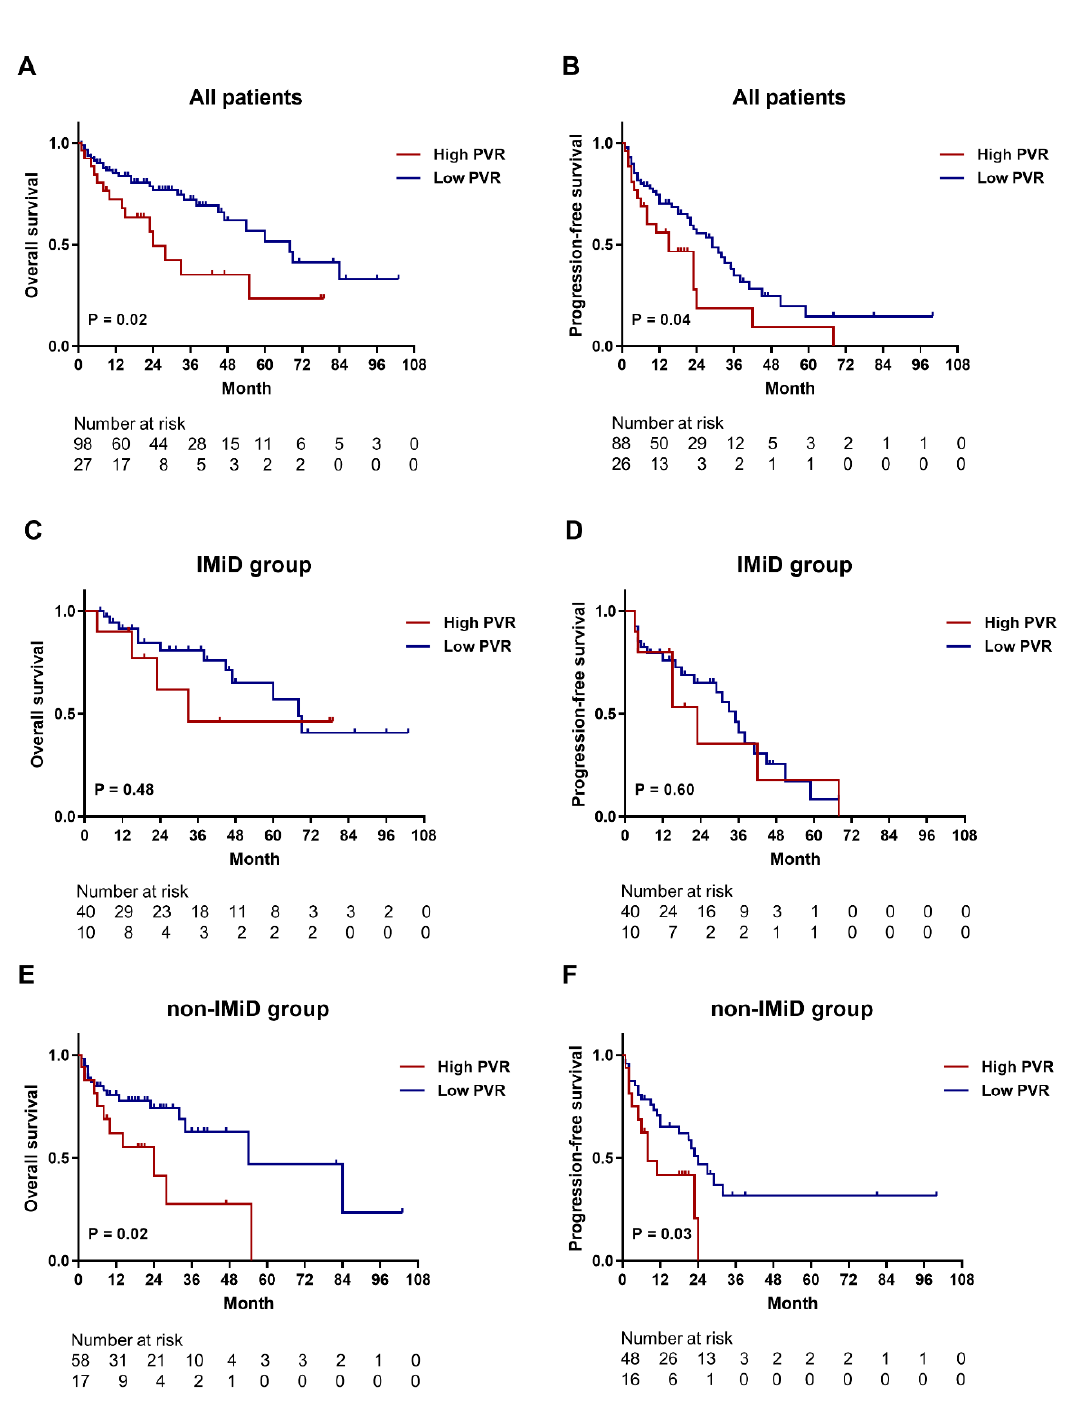
Figure 5. Kaplan–Meier survival curves for OS and PFS according to PVR expression. ( A , B ) OS and PFS curves for all patients. The median OS was 24 months in the high PVR-expression group and 68 months in the low PVR-expression group (n = 125). The median PFS was 15 and 29 months in the high and low PVR-expression groups, respectively (n = 114). ( C , D ) OS and PFS curves for the subgroups of patients (n = 50) who received IMiD therapy. The median OS (33 vs. 68 months) and PFS (23 vs. 35 months) showed no significant differences between low and high PVR-expression groups. ( E , F ) OS (n = 75) and PFS (n = 64) curves for the subgroups of patients who did not receive IMiD therapy. The median OS (24 vs. 54 months) and PFS (8 vs. 24 months) were significantly shorter in the low PVR-expression group relative to the high PVR-expression group. IMiD, immunomodulatory drug; OS, overall survival; PFS, progression-free survival; PVR, poliovirus receptor; TIGIT, cell immunoreceptor with Ig and ITIM